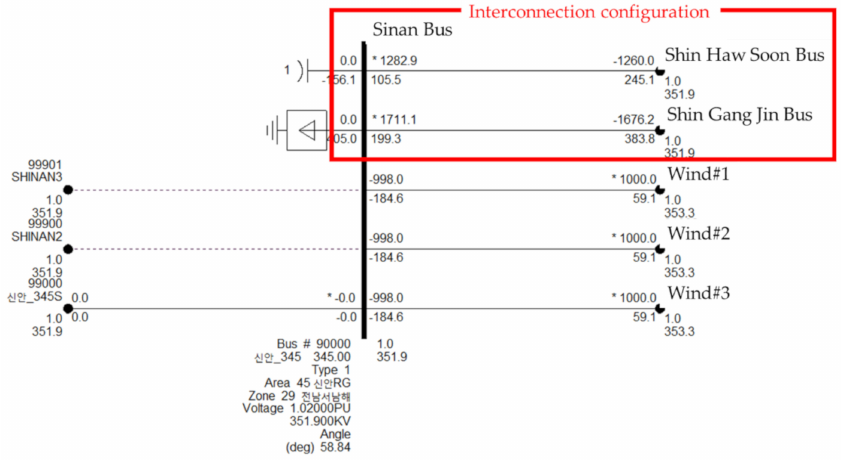
Figure A5. Interconnection configuration on PSS / E